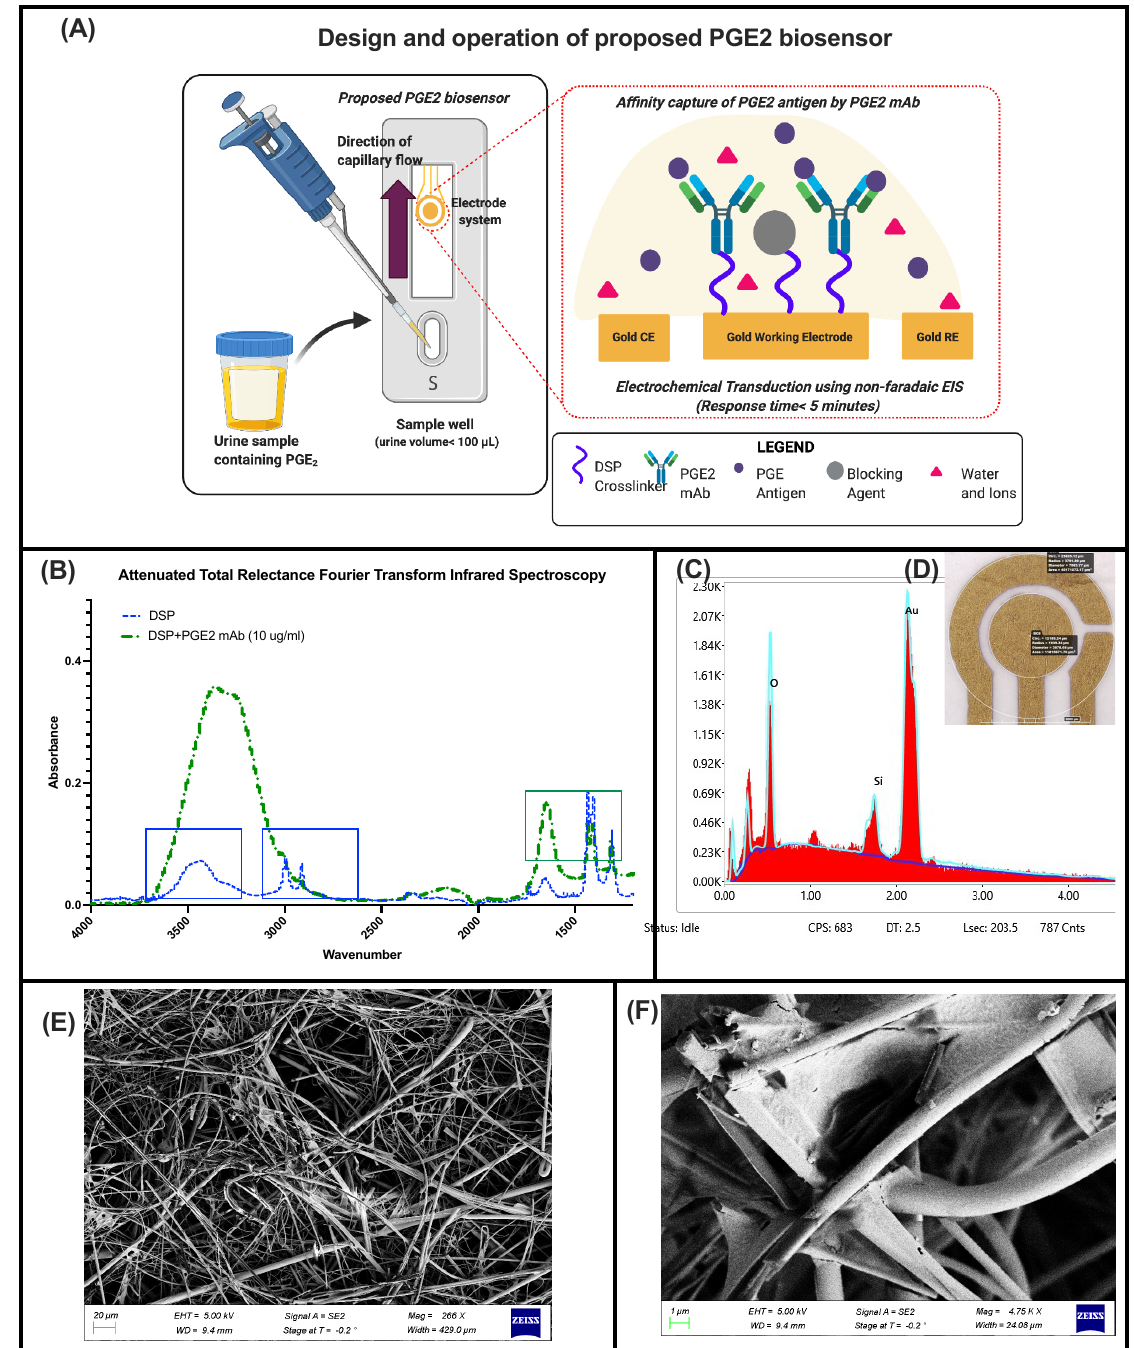
Figure 1. ( A ) Schematic showing the principle of sensor operation in non-faradaic mode and assay elements, ( B ) Attenuated Total Reflectance-Fourier Transform Infrared spectra of DSP crosslinker and DSP-monoclonal antibody conjugate, ( C ) EDAX characterization, ( D ) micrograph and ( E , F ) SEM images of gold deposited sensor on lateral flow